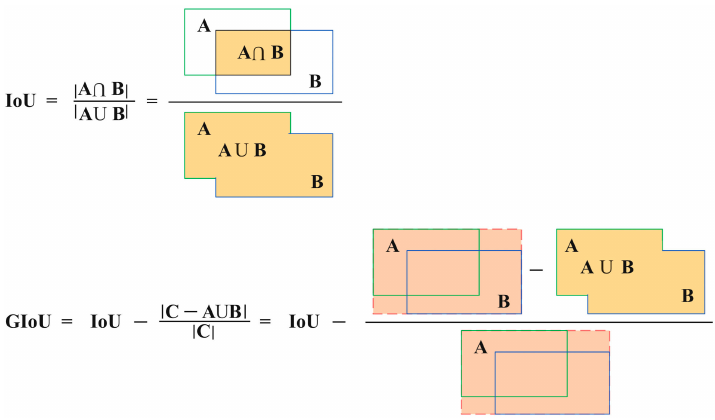
Figure 4. Diagrams of IoU and